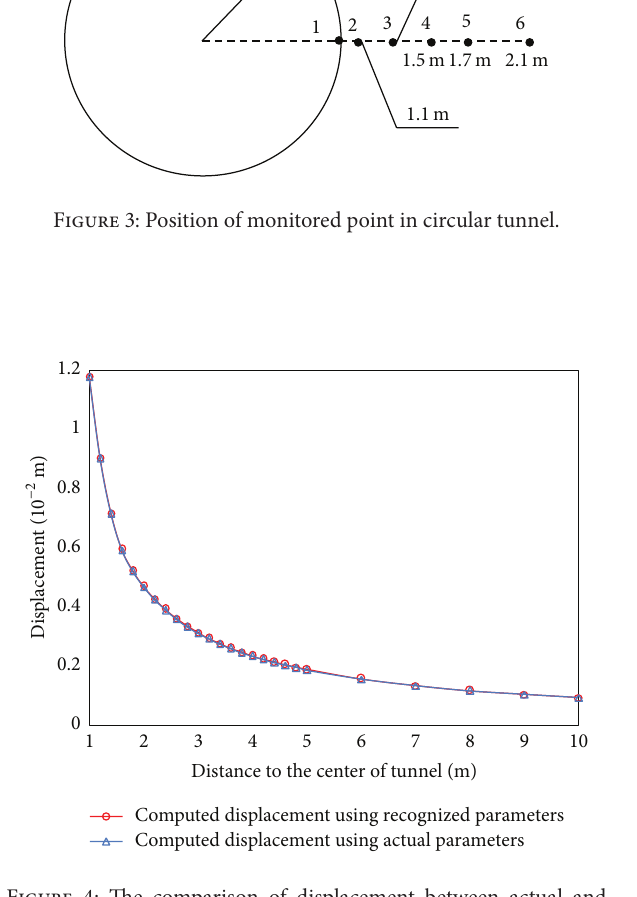
Figure 4: The comparison of displacement between actual and recognized parameters.